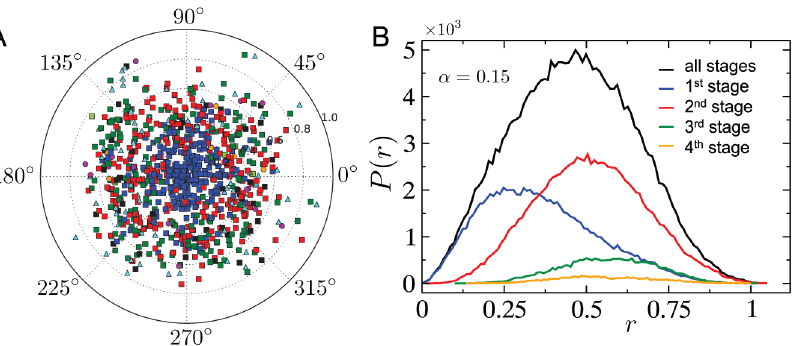
Figure 7. Location of overloaded nodes. (A) Position (distance and angle) of failed nodes relative to the initially removed one, here the highest load in the network. Different colors correspond to different iterations of the cascade: blue squares (1st), red squares (2nd), green squares (3rd), light blue triangles (4th), black squares (5th), magenta circles (6th), orange circles (7th), light green squares (8th), yellow triangles (9th). Network parameters are the same as in Fig. 1, while each data point is the averaged location of nodes removed in a given stage over 300 independent network cascades. (B) The distribution of the distance r from the cascade-triggering node for nodes that fail in the course of a cascade (See text for details).